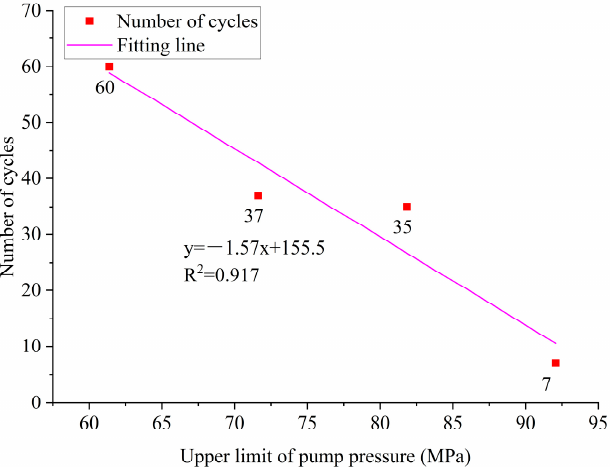
Figure 11. The relationship between the upper limit of cyclic pump pressure and the cycles required for breakdown.